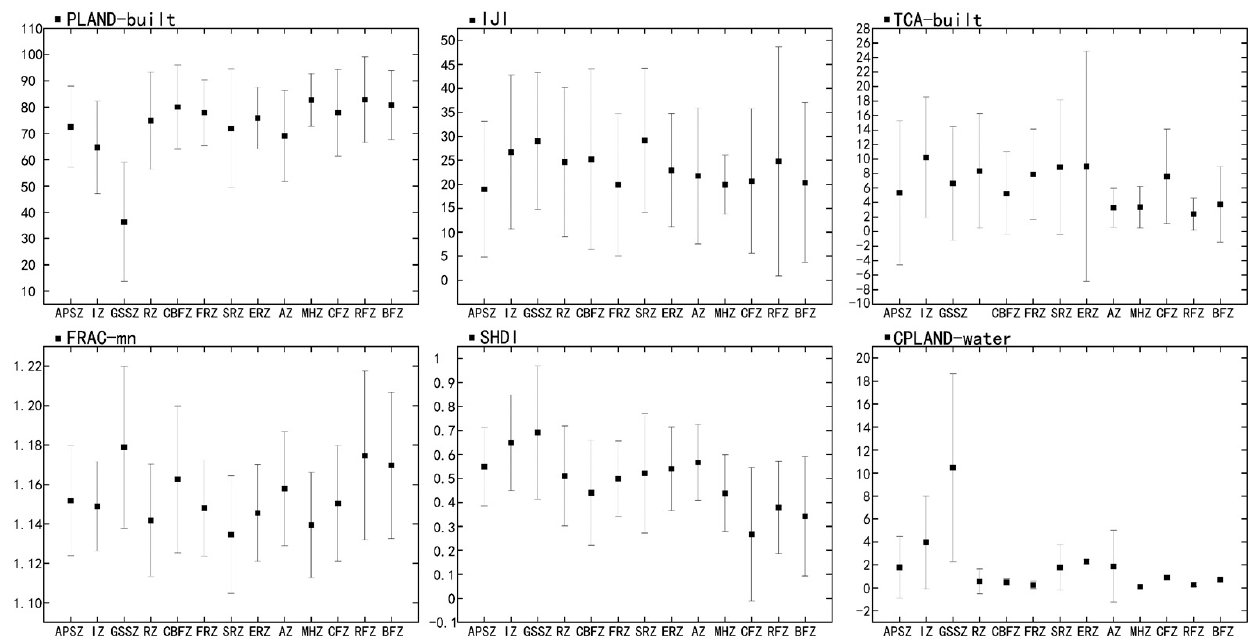
Figure 6. Statistics for the distribution of landscape structures.